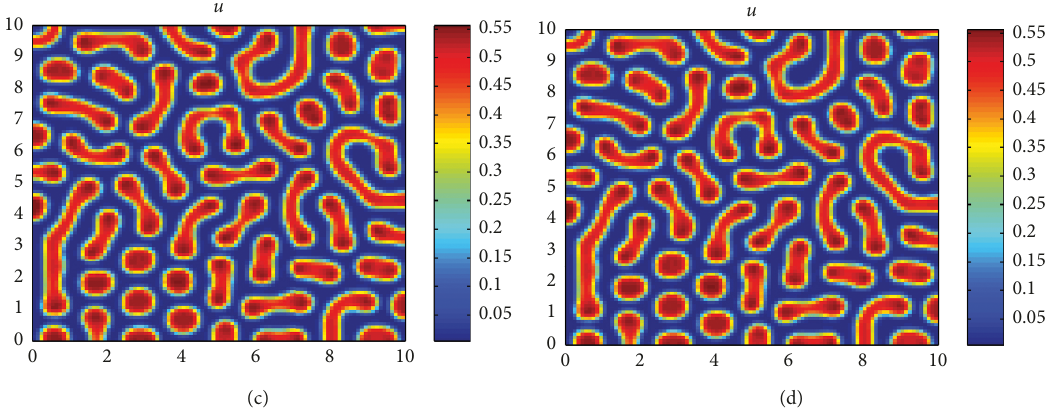
Figure 2: Mixture patterns obtained with model (1) for A � 0 . 02 and τ � 0. Time: (a) t � 100, (b) t � 500, (c) t � 2000, and (d) t � 5000.